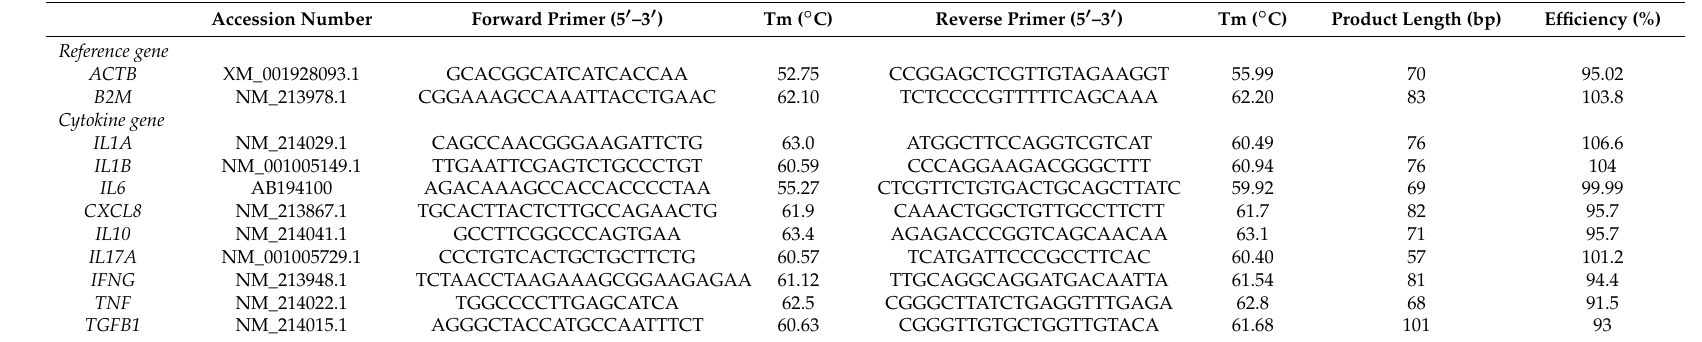
Table 1. Oligonucleotide sequences of forward and reverse primers used in